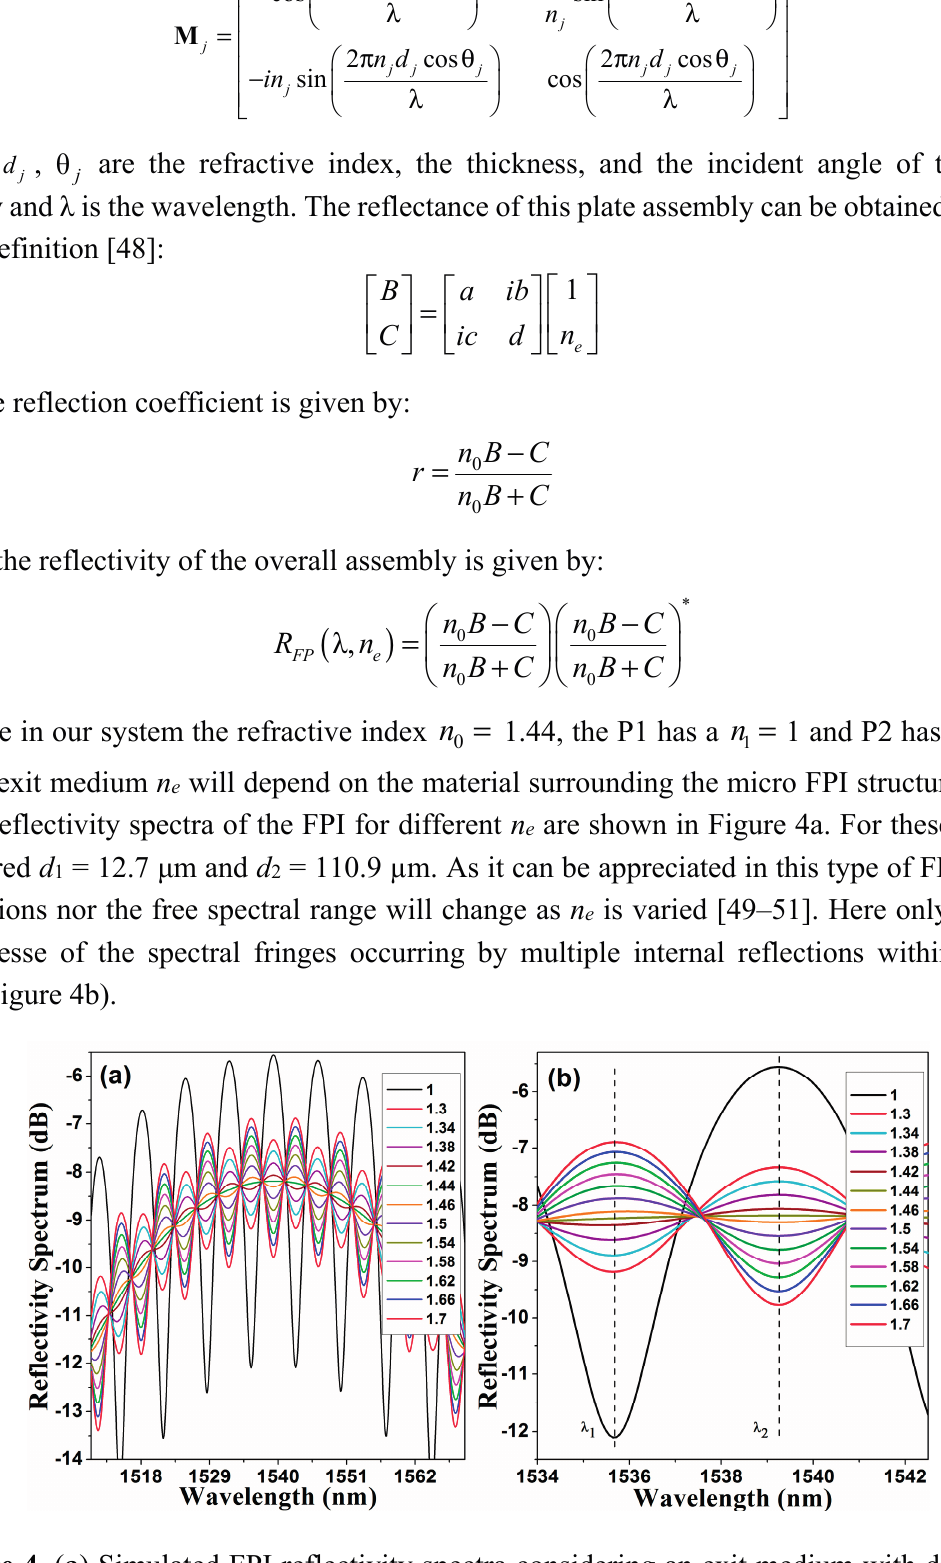
Figure 4. ( a ) Simulated FPI reflectivity spectra considering an exit medium with different refractive indexes; ( b ) Detail of the FPI reflectivity spectra showing a single fringe peak and